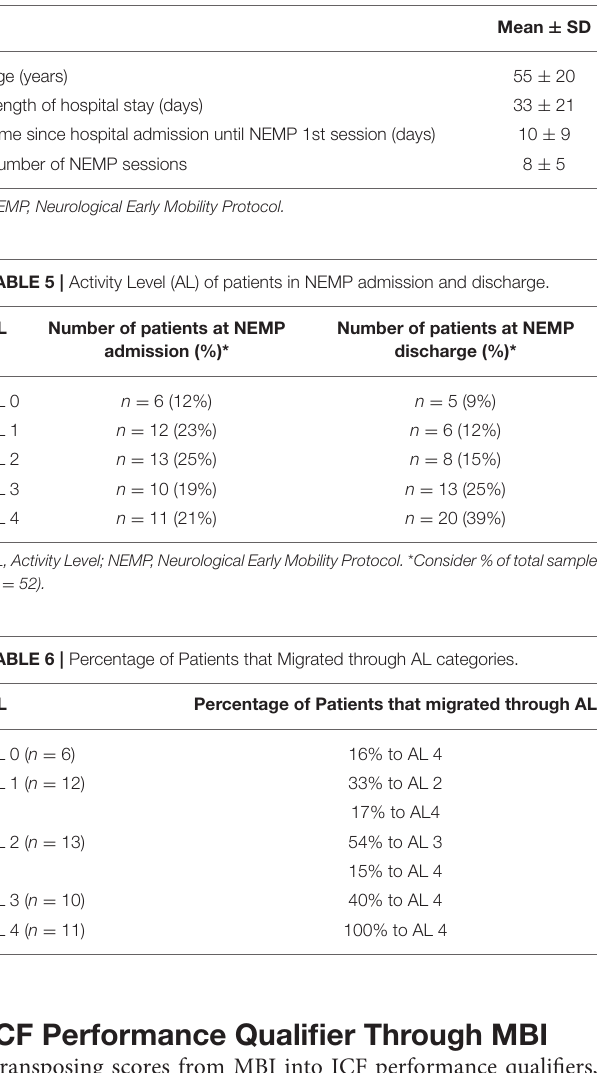
TABLE 4 | Baseline characteristics of the treated population.